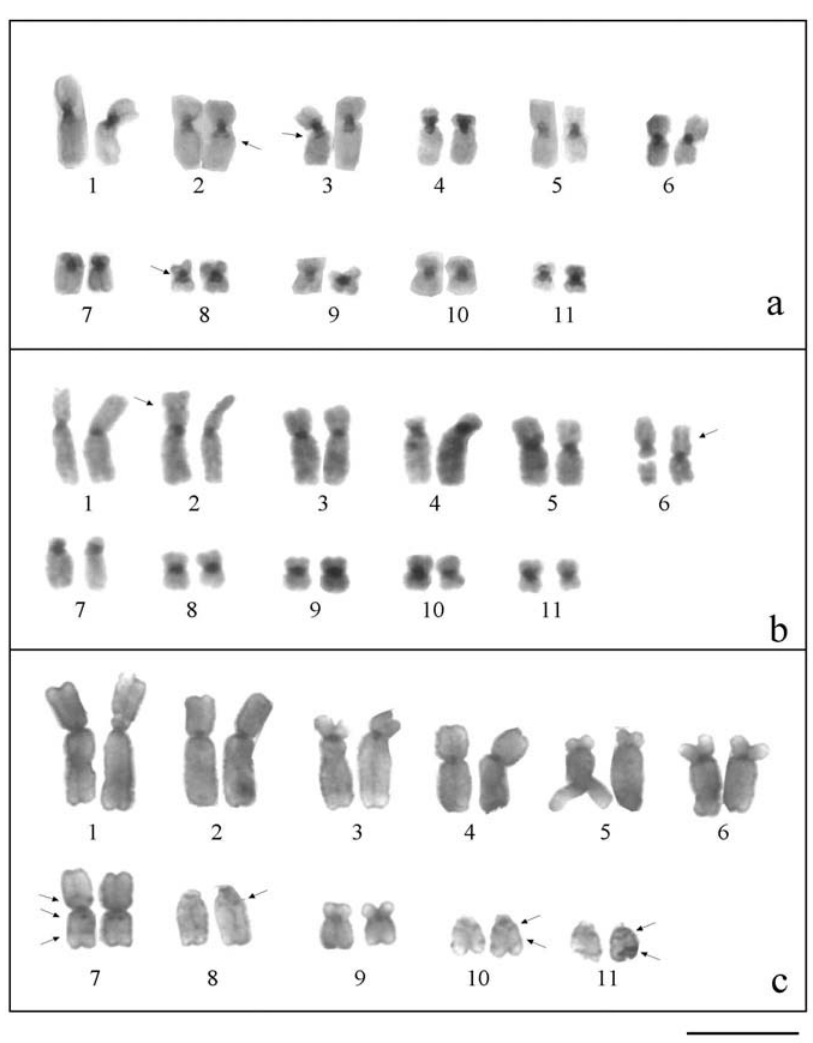
Figure 3 - Karyotypes of E. guentheri ( a ), E. parvus ( b ) and E. binotatus ( c ) after C-banding. The arrows indicate the interstitial heterochromatin. Bar = 10 µ